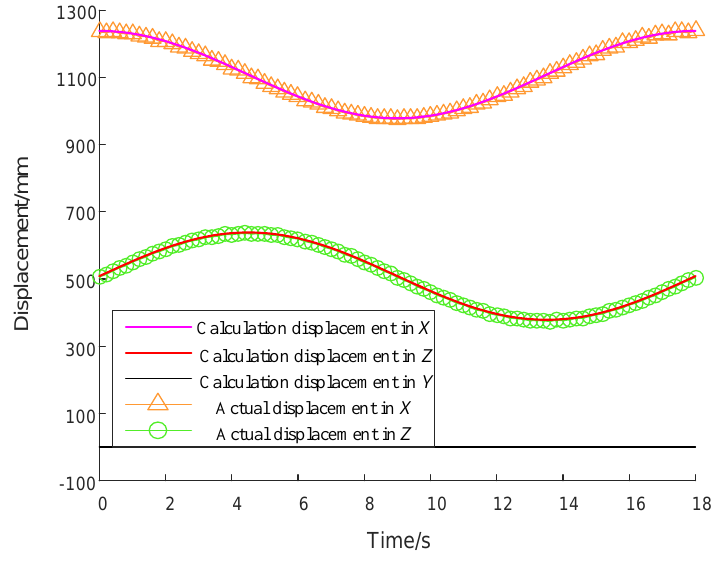
Figure 14. Comparisons of displacements between the theoretical and the experiment.